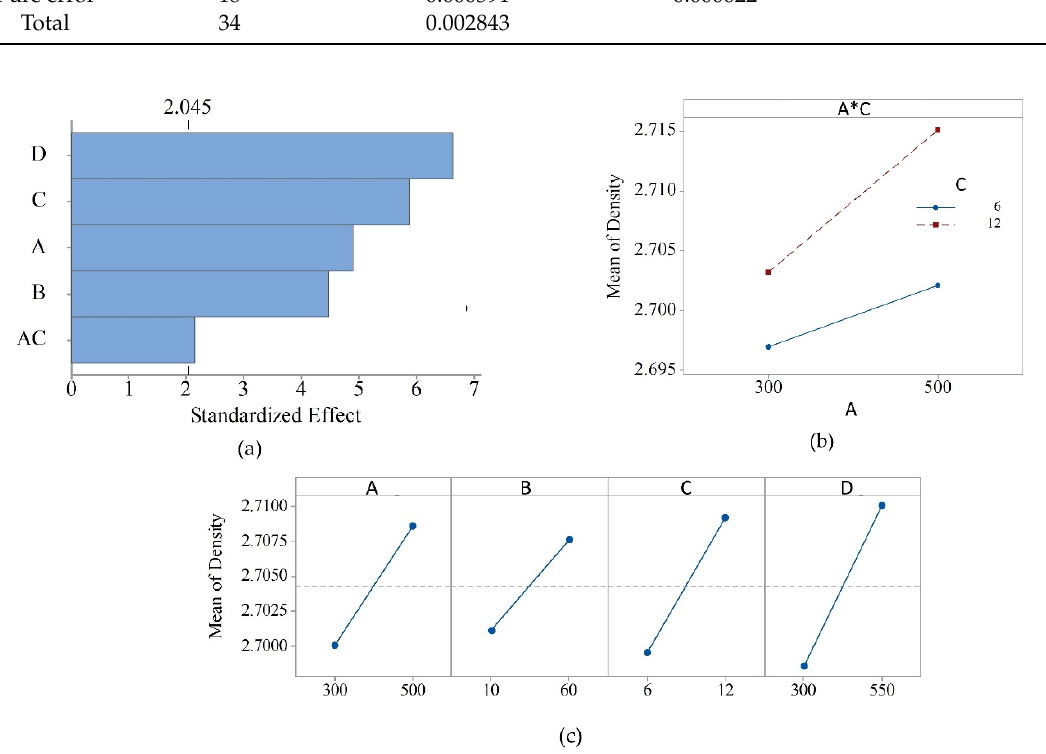
Figure 5. ANOVA results; ( a ) standardized effect; ( b ) interaction effect between chip treatment temperature and extrusion ratio; ( c ) main effect plot.